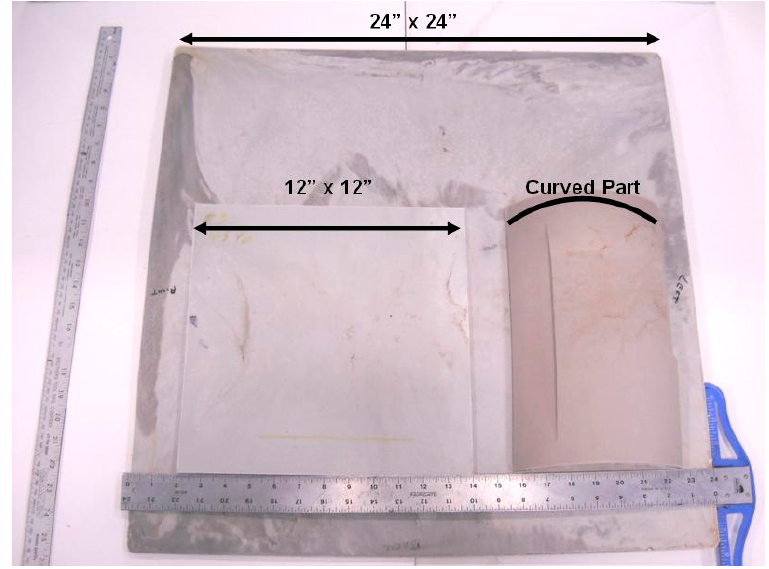
Figure 22. Scale up and shape illustration. PP-GF panels of various sizes and shapes produced from scrap/recycled materials. Demonstration of ability to scale-up the process into panels and curved shapes for parts The large plate is 600 mm × 600 mm (24 ″ × 24 ″ ) and the small plate is 300 mm × 300 mm (12 ″ × 12 ″ ) in dimension.